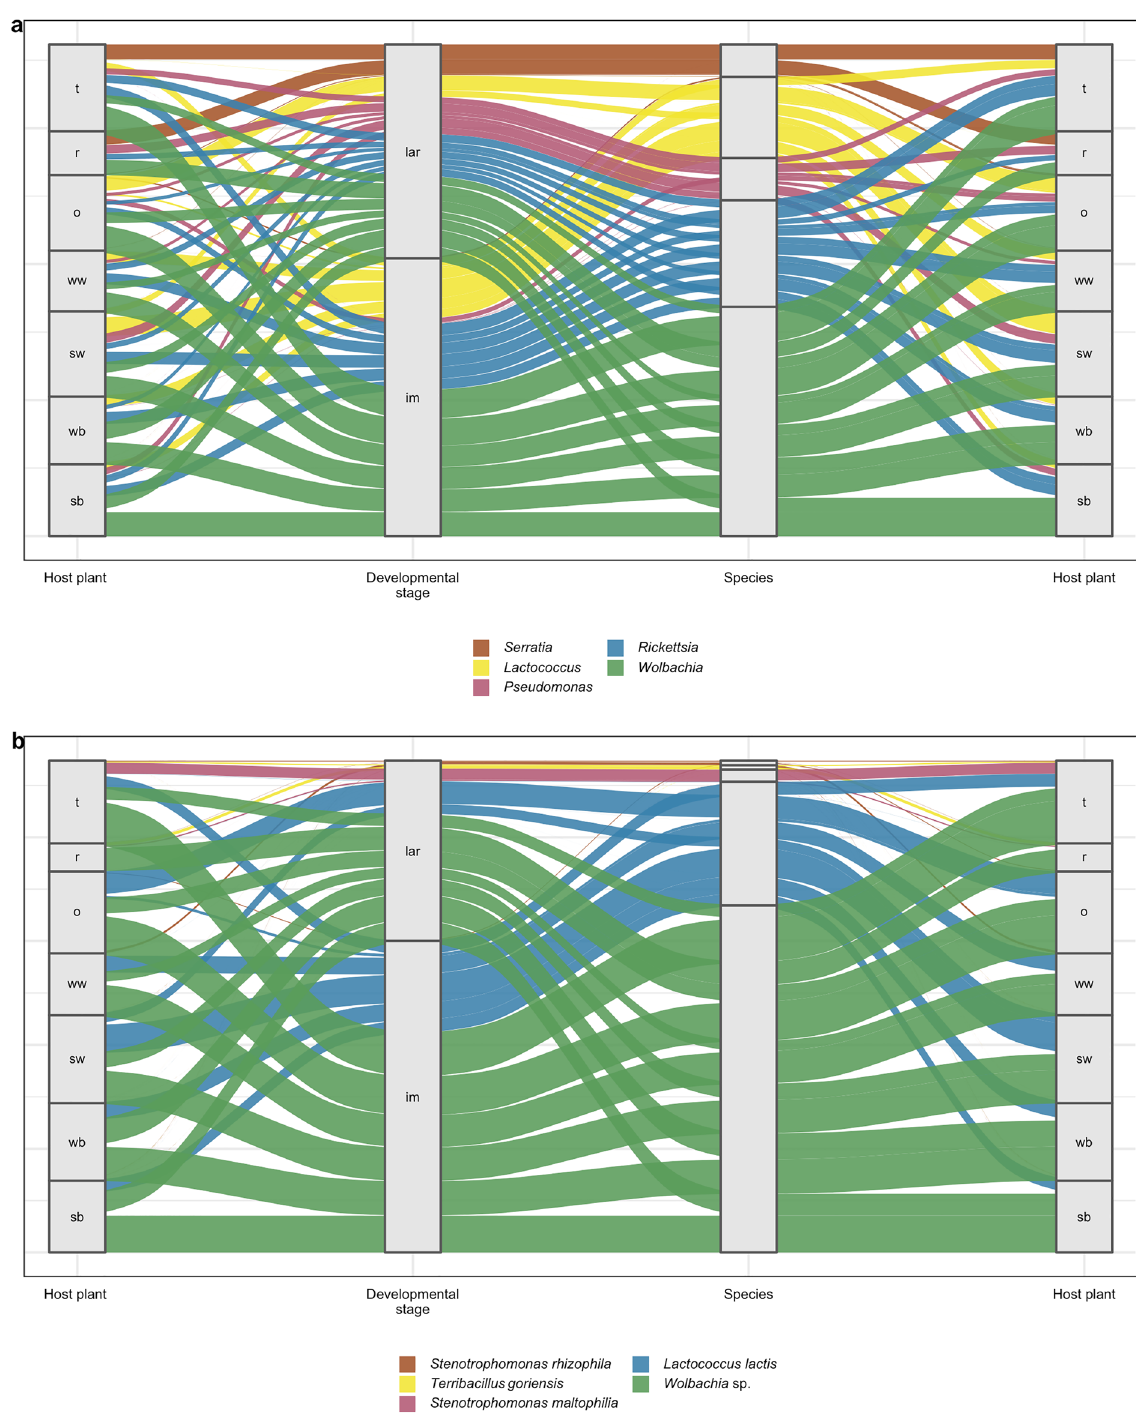
Figure 8. Distribution of 5 the most abundant ( a ) genera and ( b ) species of bacteria of Top Biome depending on the variable: developmental stage (larva, imago) and cereal plant host from which insects were collected. The Sankey diagram has been made on the basis of the percentage values of taxa occurrence excluding samples with zero values. sb: spring barley; wb: winter barley; o: oat; sw: spring wheat; ww: winter wheat; t: triticale; r: